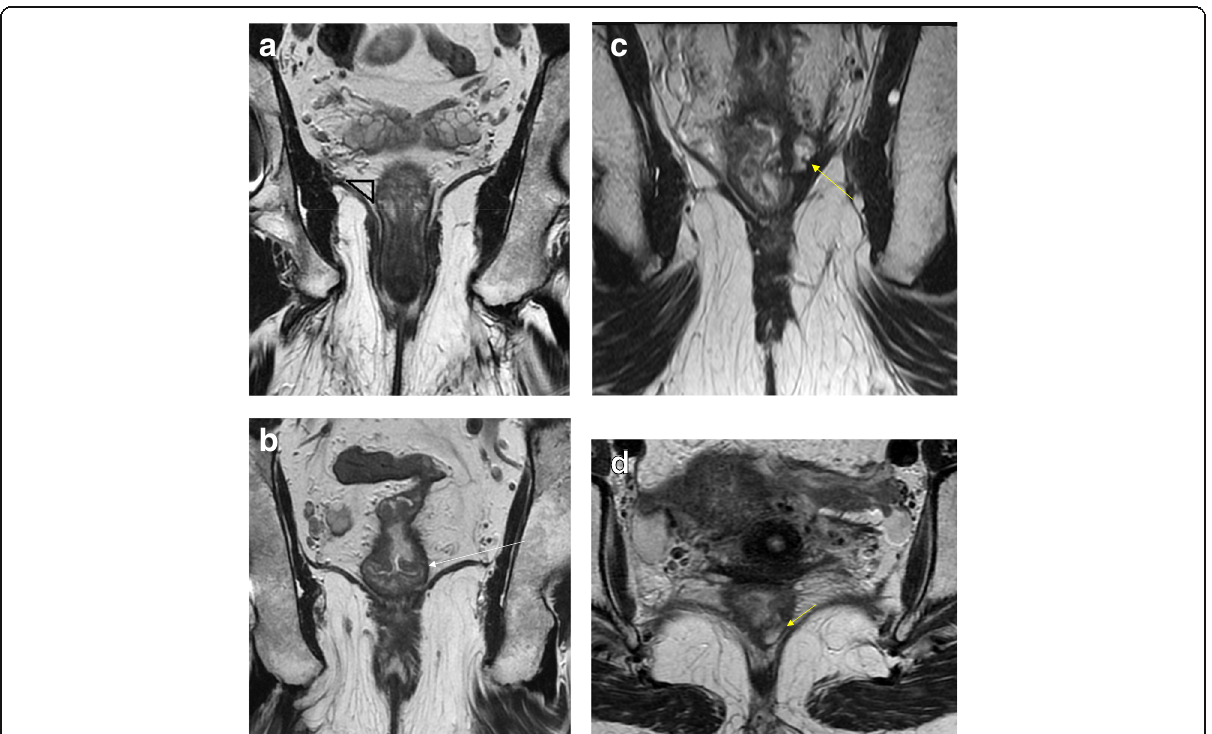
Fig. 8 The assessment of the intersphincteric plane safety. a Coronal T2WI shows the normal anal canal anatomy. The distal tapering of the mesorectal fat is shown by the black triangle that delineates the fat content on the upper portion or the dissection plane when low anterior resection is performed. b Coronal T2WI shows the distal edge of the lesion (arrow) above the intersphincteric plane. Low anterior resection is possible with no risk of margin positivity at this level. c Coronal T2WI shows the distal edge of the lesion lying in the plane of the levators. There is lateral spread with mucinous content on the left, threatening the intersphincteric plane (arrow). d High-resolution axial T2WI shows a residual low-lying lesion partially invading the muscularis propria (arrow). Intersphincteric resection would be safely performed. A clear resection margin was